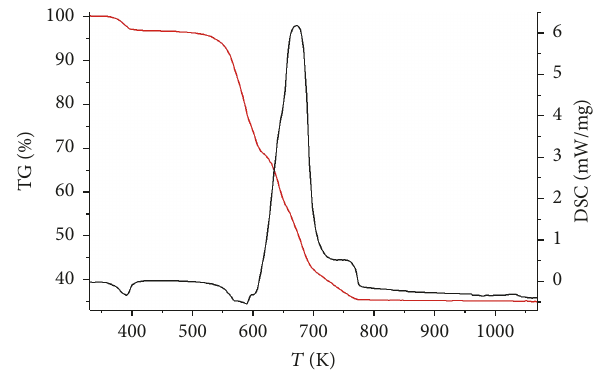
Figure 2: TG and DSC decomposition C 6 H 10 (NH 3 ) 2 [PtCl 6 ] ⋅ H 2 O (I) .